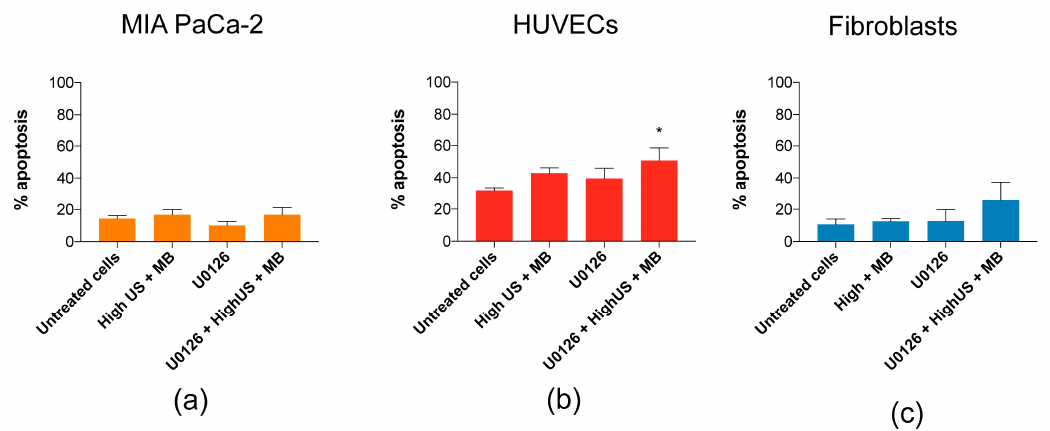
Figure 6. Inhibition of MEK / ERK with U0126 in combination with high US + MBs increased the percentage of apoptotic ( b ) HUVECs ( p < 0.05) and ( c ) fibroblasts, but not ( a ) MIA PaCa-2. Mean ± SEM, * p < 0.05 (treated vs. untreated